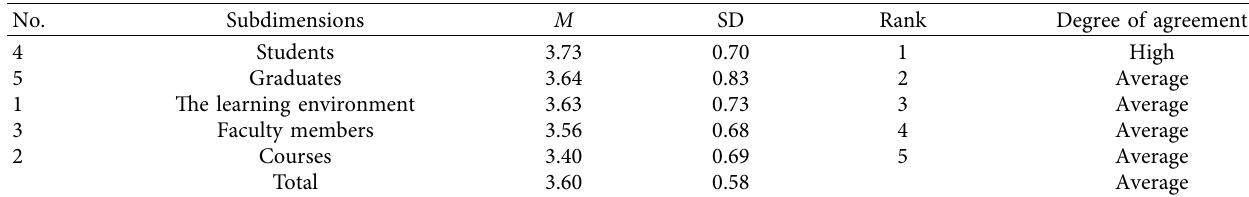
Table 3: Descriptives of the requirements for employing artificial intelligence applications among PSAU students in descending order.